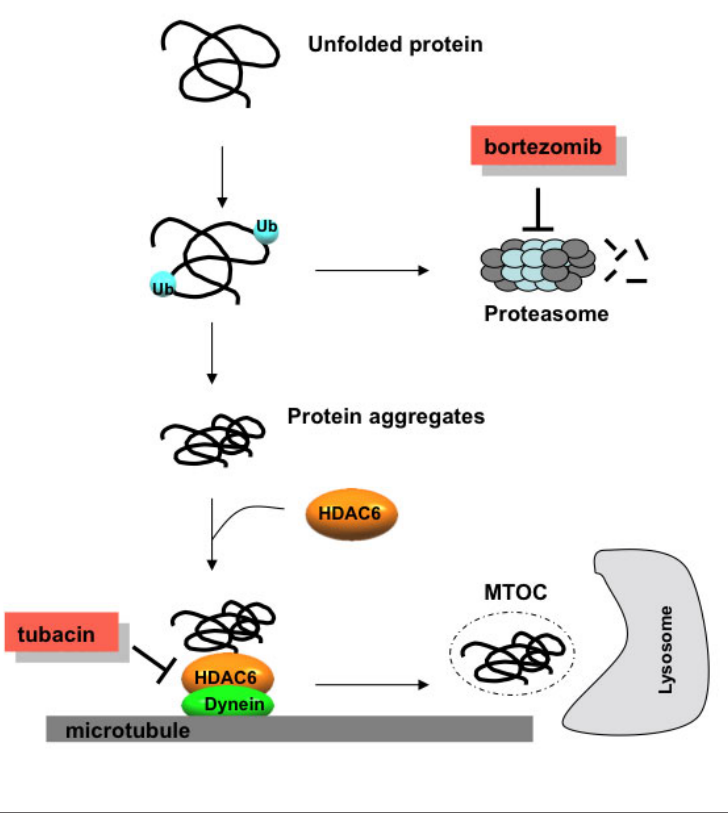
Figure 2. The aggresome pathway prevents accumulation of misfolded proteins. Unfolded or misfolded proteins, that exceed proteasomal degradation, form aggregates and are transported to the microtubule organizing center (MTOC) for degradation. This trans- port requires HDAC6 which deacetylates alfa-tubulin and binds both polyubiquitinated proteins and dynein. Inhibiting HDAC6 with tubacin, whether or not combined with the proteasome inhibitor bortezomib, accumulates misfolded or unfolded proteins and leads to